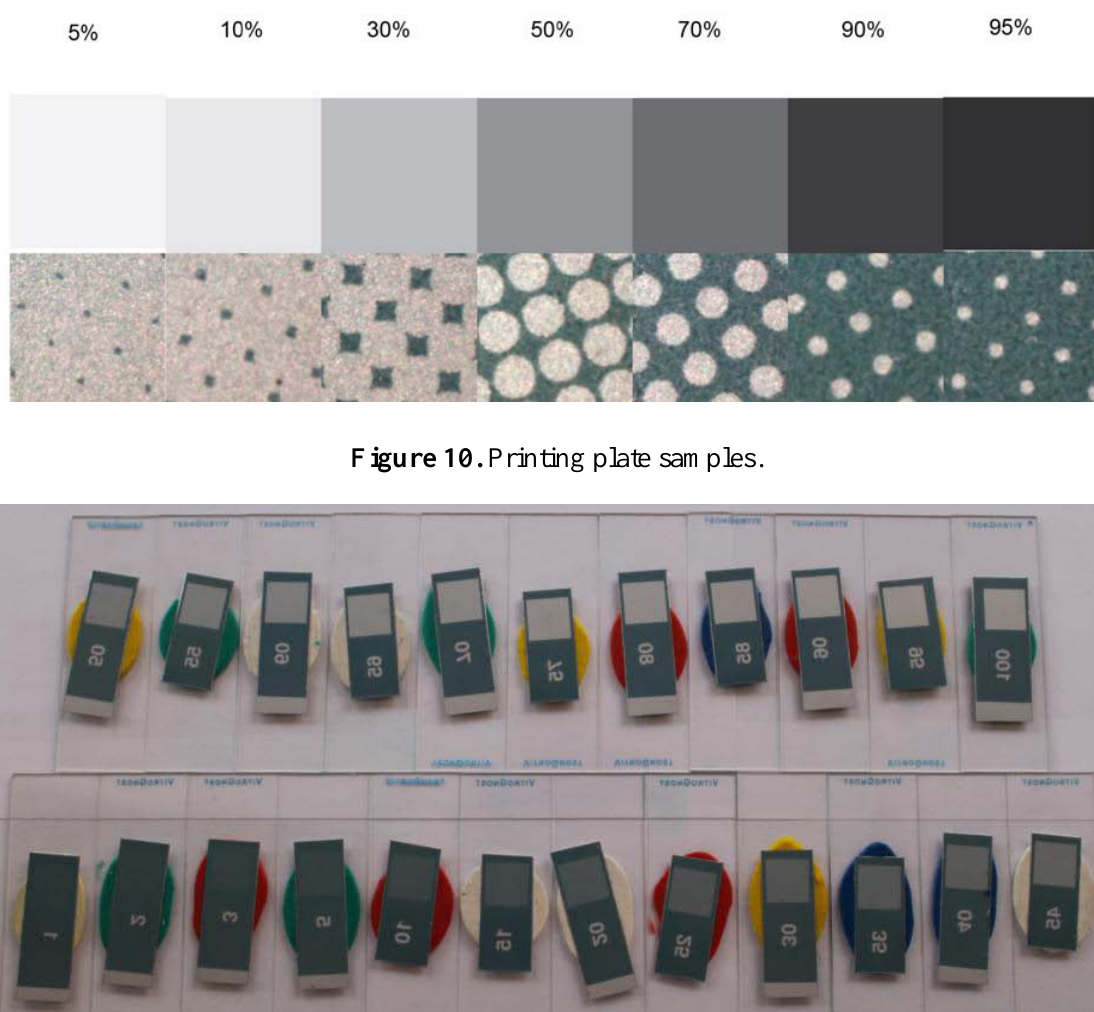
Figure 9. Control wedge vs. VipFLEX images.